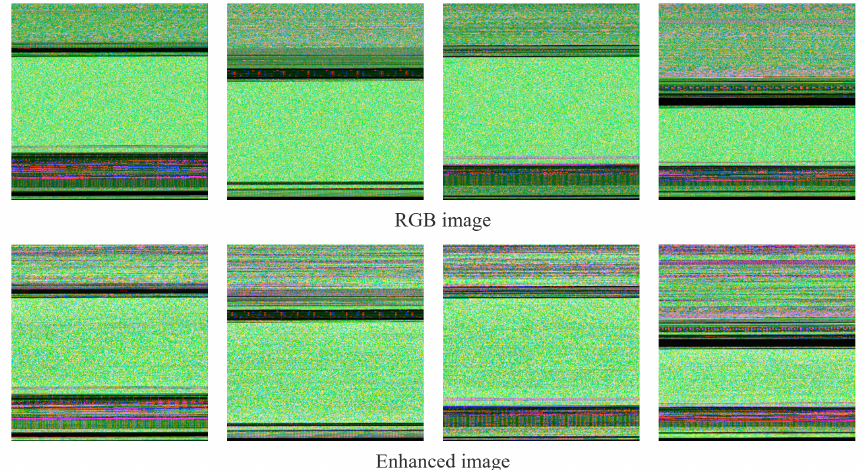
Figure 4. Images before and after processing with the data enhancement